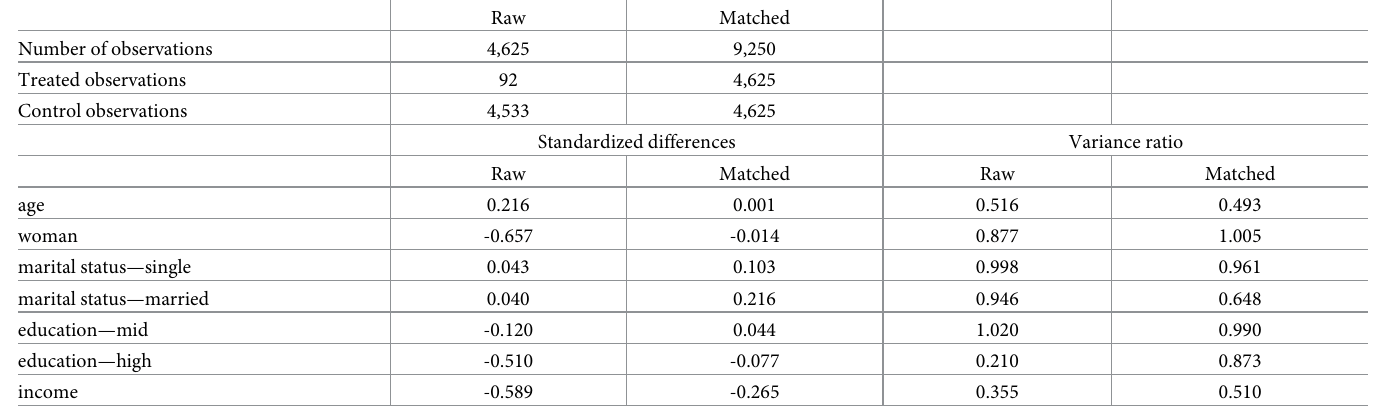
Table 6. Covariate balance summary weight matching 6